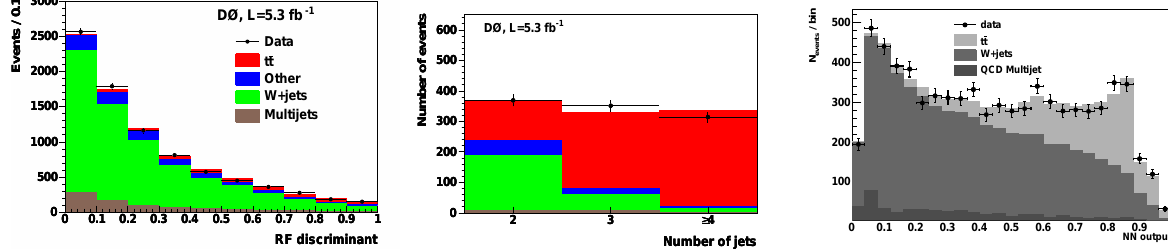
Fig. 1. RF discriminant output for events with three jets and no b -tags (left) and jet multiplicity spectrum of events with at least 2 b -tags (middle) from D0 analysis, NN output for events with 3 jets from CDF analysis (right). ≥